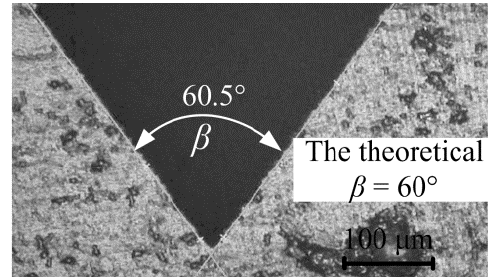
Figure 8. The V-tip section shape of trued grinding wheel.